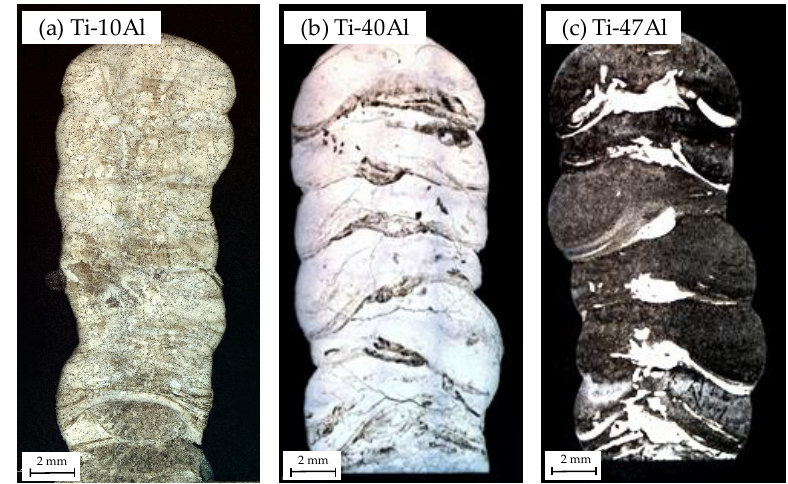
Figure 4. Cross sections of Ti–Al samples with aluminum concentrations of ( a ) 10 at%, ( b ) 40 at%, ( c ) 47 at%.